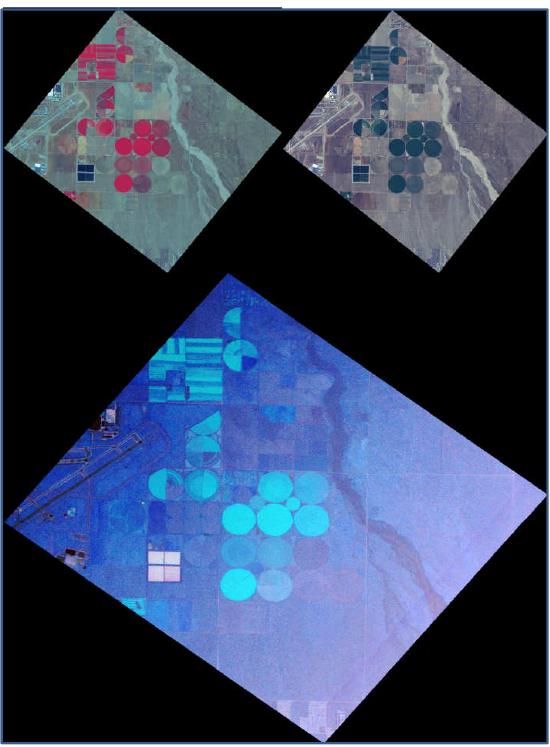
Figure 2. Sample of AirMSPI imagery acquired on the first engineering flight over Palmdale on October 7, 2010. Top left – 470, 660, 865 nm Intensity; Top right – 445, 555, 660 nm Intensity; Bottom – 470, 660, 865 nm DOLP So, after some manual time alignments with existing navigation data, to remove gross errors, we projected the imagery without any pointing correction. Even though the absolute geolocation was significantly off target, the band-to-band co-registration within any “step and stare” view angle was accurate, as anticipated. This demonstrated that our camera internal